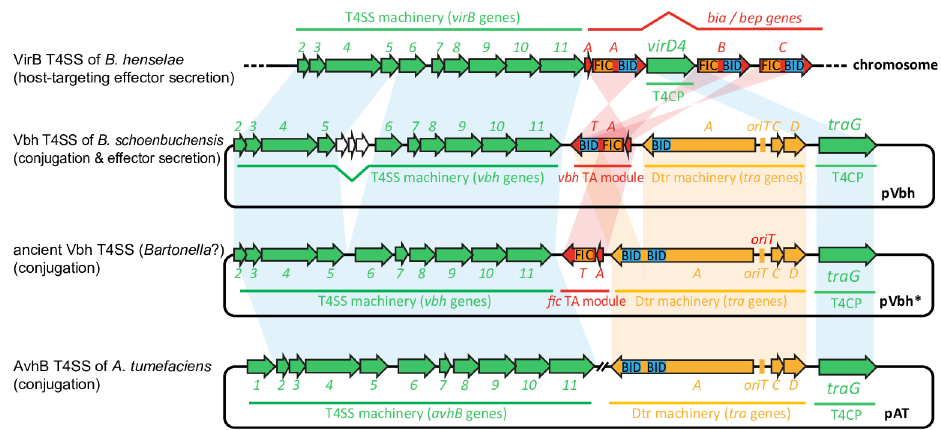
Fig 7. Working model: A VbhT-like interbacterial effectoras a missing link in the evolution of Beps from FicT toxins. The modelillustrates the homology of genesassociated with differentT4SS machineries rangingfrom a regularconjugationsystem (represented by the AvhB T4SS of A . tumefaciens ,bottom) to a host-targeting, effector secretingvirulencefactor (VirB T4SS of B . henselae ,top). Corecomponentsof the T4SS machinery and the T4CP are shown in green, the Dtr machineryis shownin yellow,and TA modulesor effectors are shown in red. Note that the VbhTA moduleof B . schoenbuchensis pVbh (second from top) displaysthe same domainarchitectureas the majority of extant Beps and likely their common ancestor. Like VbhT, the most upstream Bep (BepA) is encodedwith a FicA antitoxin that is calledBiaA in the context host- targeted Bartonella effectors [11].Based on the genomicislandswith Vbh-likeT4SS and FicTA moduleslike BtrFicTA (Fig 4), we infer an ancientpVbh-likeplasmidin whicha FicTA modulewas encodedbetweenthe conjugative relaxaseand the T4SS machinery(secondfrom bottom). It is clearly apparent that a DNA rearrangement fusing one BID domainof the relaxasewith the FicT toxin–i.e.,classicalterminal reassortment– wouldcreate a VbhT-likeinterbacterial effector as evidencedby the clear compositearchitectureof this protein (Fig 6). We therefore speculate basedon these homologies that an evolutionary processfrom the bottom to the top of this modelmay approximate the evolutionary history of the host-targeting VirB